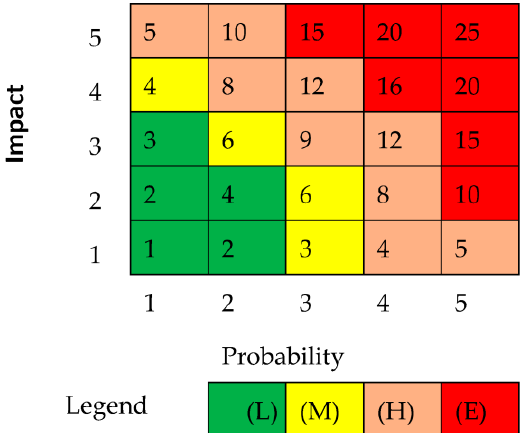
Figure 5. Risk matrix.